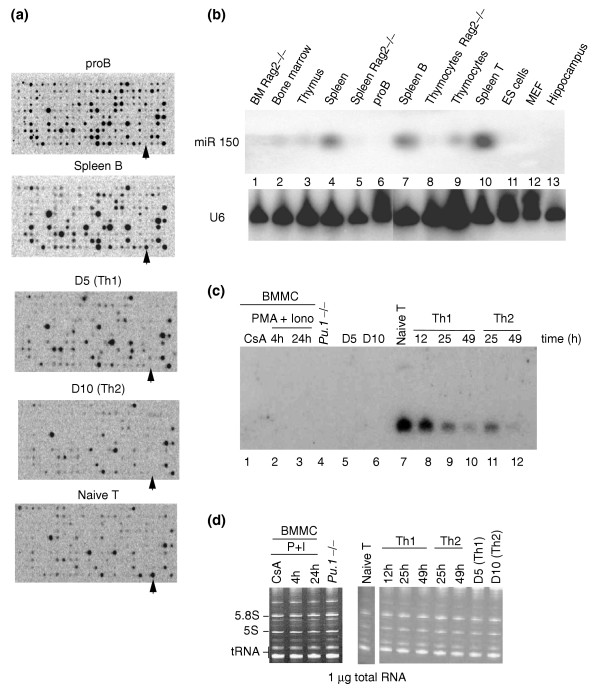
Comparison of miR-150 expression by arrays and Northern blotting. (a) Array data show that miR-150 (arrows) is highly expressed in spleen B and naïve T cells, but not in pro-B cells or fully differentiated Th1 and Th2 clones. (b) Northern blot analysis for miR-150 in various lymphoid and non-lymphoid tissues and cell types. U6 RNA levels are shown as loading control. (c) Northern blots of different cell types unstimulated or stimulated for the indicated amounts of time with either PMA and ionomycin (BMMC) or anti-CD3 and anti-CD28 (Th1 and Th2 primary cells). Preliminary data obtained both in Northern blot and arrays showed no difference in miRNA expression between BMMC left untreated or treated with cyclosporin A (CsA) (not shown). (d) Ethidium bromide staining of gel of total RNA from samples used in Figure 2c, showing equivalent RNA amounts. BMMC, bone marrow-derived mast cells; MEF, mouse embryo fibroblast.